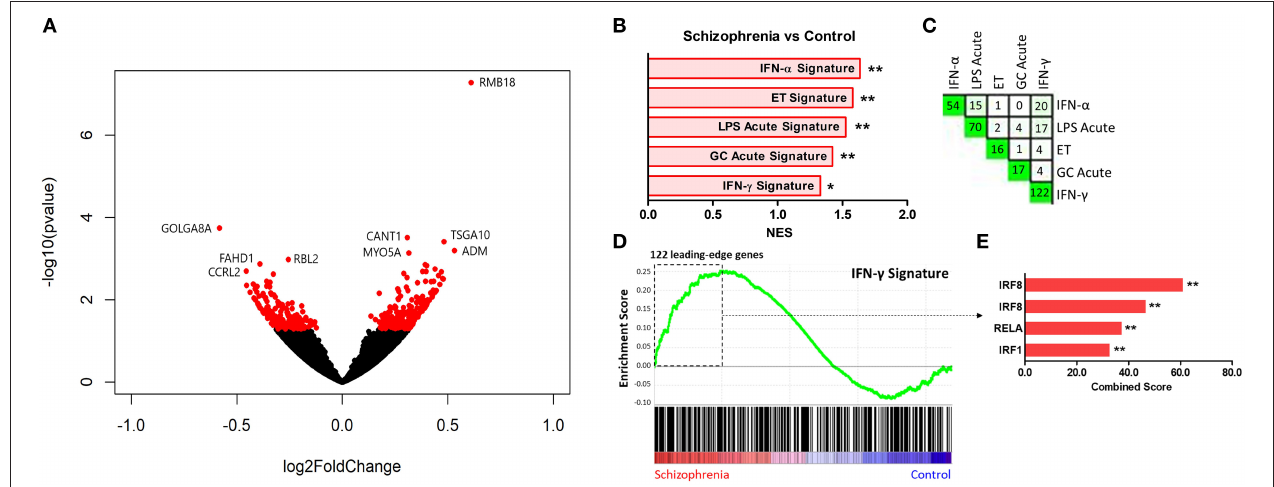
FIGURE 2 | (A) Volcano plot of DGE: schizophrenia vs. controls. On the x-axis is log fold change of genes in participants with schizophrenia compared to controls, points to the right of 0 represent genes that are increased, and points to the left of 0 genes that are decreased, in schizophrenia compared to controls. Statistical significance is displayed on the y-axis, and p < 0.05 are labeled in red. Select genes with both high fold change and significance are labeled. (B) Signatures that were enriched in the schizophrenia group compared to controls. **FDR < 0.05, *FDR < 0.25. NES, normalized enrichment score. (C) Leading-edge analysis for signatures enriched amongst genes overexpressed in schizophrenia. The numbers indicate the number of leading-edge subset genes , for example there were 54 leading-edge subset genes for the “IFN- α signature,” as well as the number of overlapping leading-edge subset genes between the corresponding signatures, for example 15 genes overlap in the “IFN- α signature” and the “LPS acute signature” leading-edge subset genes . This number is also represented by the green gradient. (D) Enrichment plot for the IFN- γ signature in participants with schizophrenia compared to controls. Genes are ranked from greatest increase to the greatest decrease in expression in schizophrenia compared to controls. Black lines indicate the location of genes that are in both the ranked list and gene set . (E) Top four results from the TFEA of the leading-edge subset genes in the IFN- γ signature. ** p < 0.001 and adjusted p <